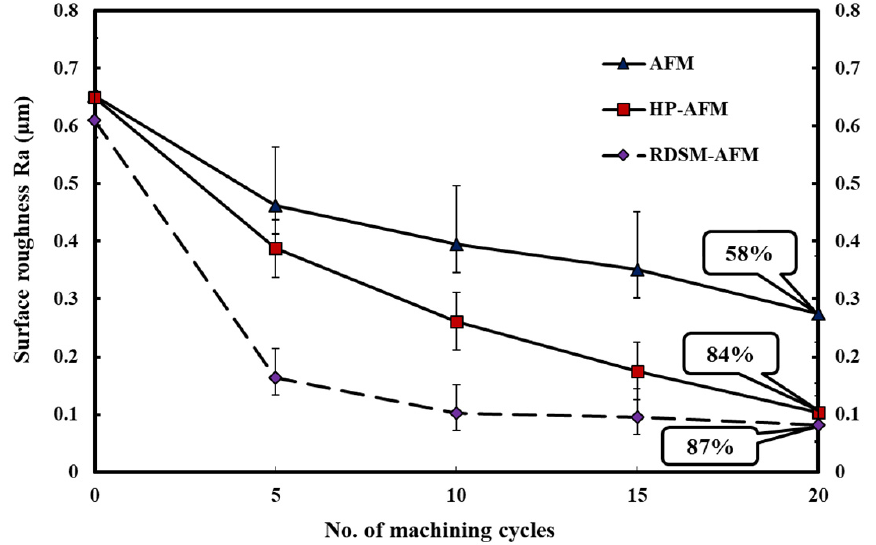
Figure 12. Effects of AFM methods on surface roughness.